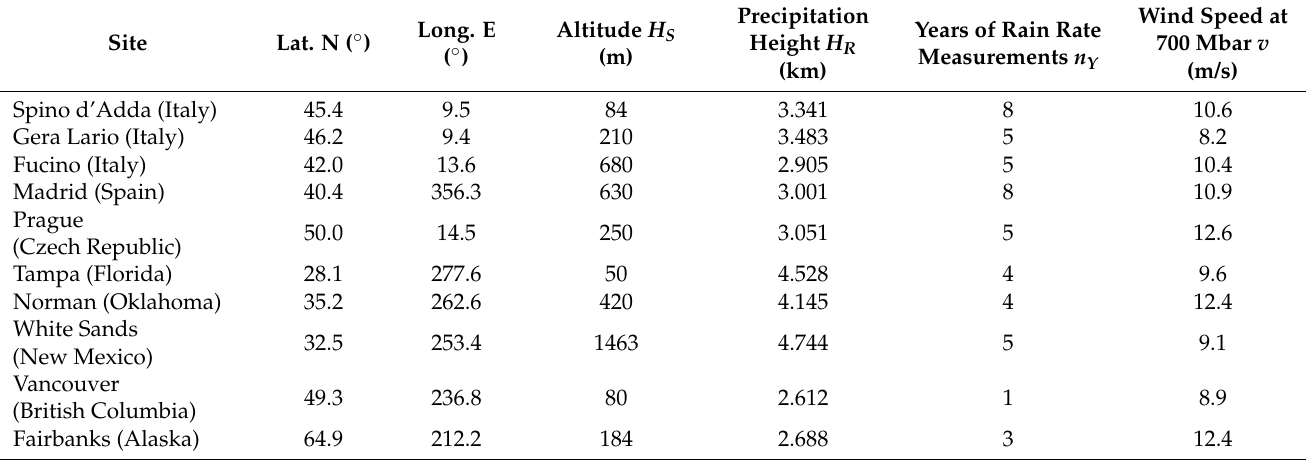
Table 2. Geographical coordinates, altitude (m), rain height H R (km) [42], number of years n Y of continuous rain rate measurements and wind speed v (m/s) at 700 mbar altitude [40], except for Spino d’Adda whose rain storm speed was estimated from radar measurements